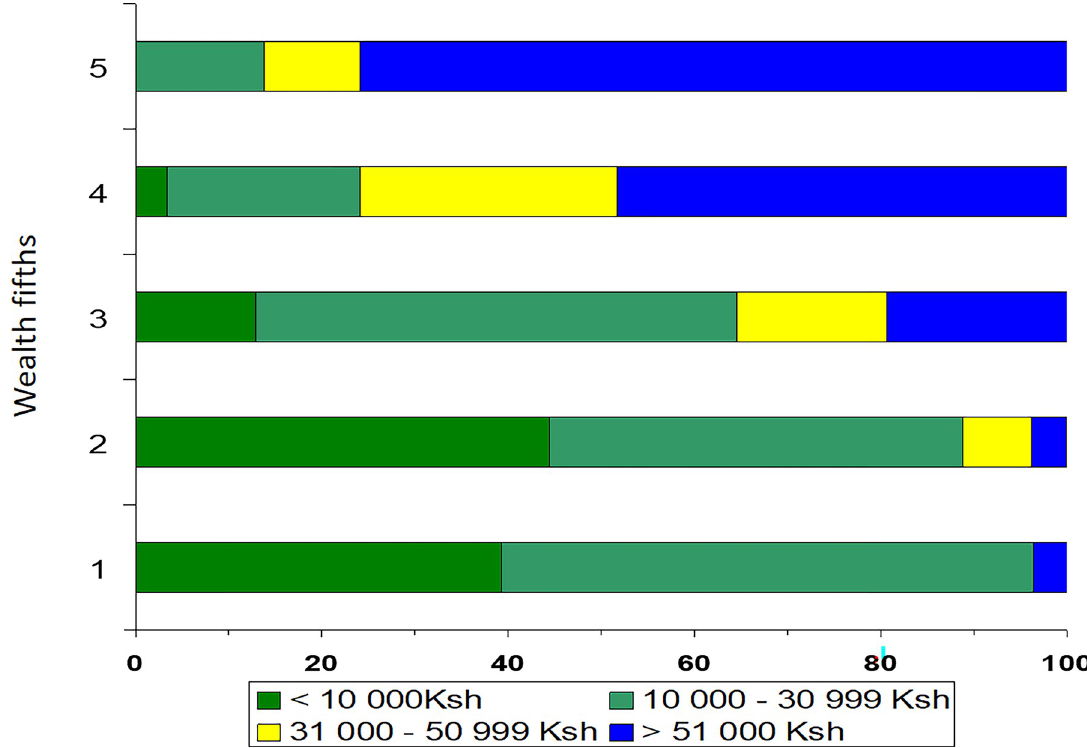
Fig 1. Distribution of income classes among individuals in fifths of wealth index, among 149 households from two sub-counties in Nairobi County, Kenya. Ksh = Kenyan shillings.